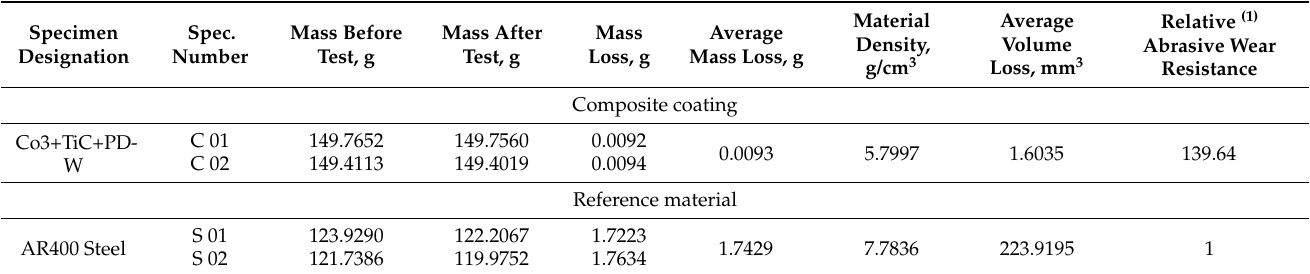
Table 7. Results of the mineral-metal abrasive wear resistance tests concerning the surface layer (PPTAW metal deposition method, Co3+TiC+PD-W composite powder) deposited on structural low-alloy steel AISI 4715 in comparison with the abrasive wear resistance of abrasion-resistant steel AR400.